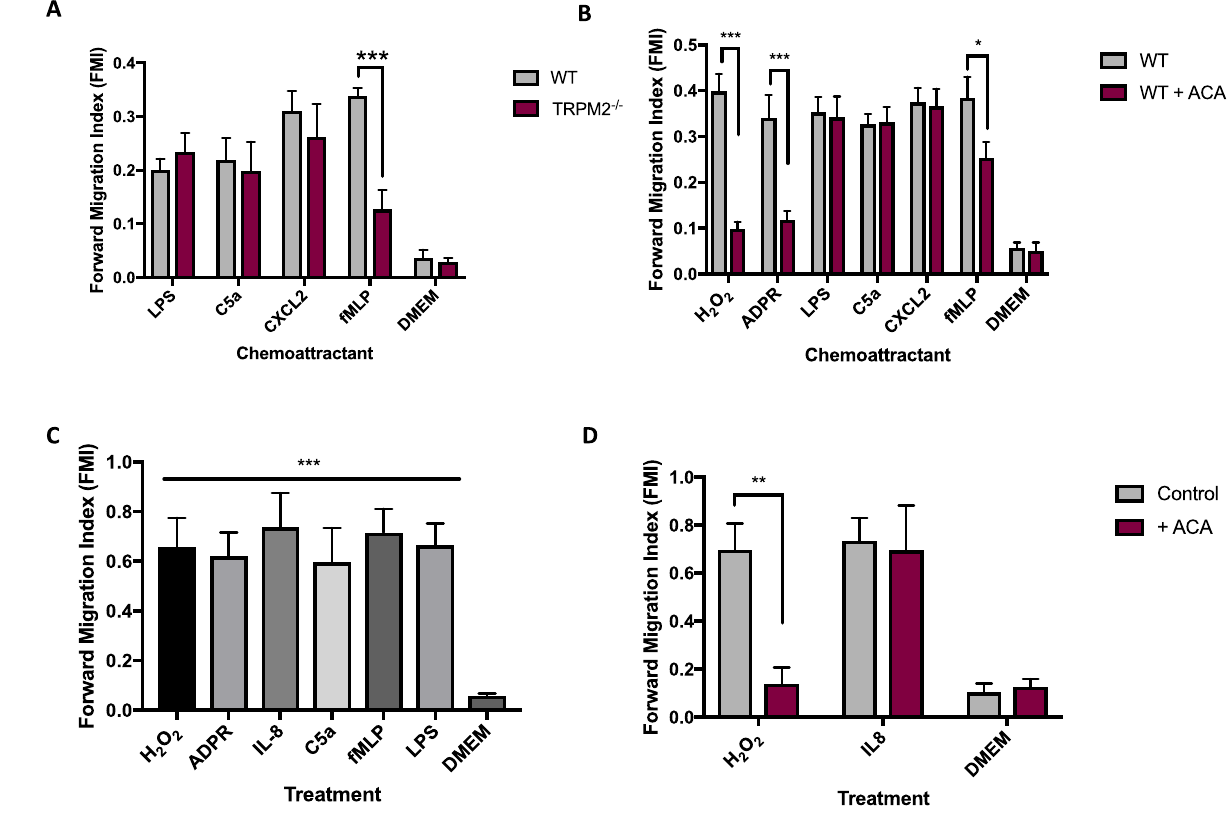
Figure 2. Dependence on TRPM2 of migration towards neutrophil chemoattractants. ( A ) Effect of genetic deletion of TRPM2 on mouse neutrophil migration. Forward migration index (FMI) in response to gradient of lipopolysaccharide (LPS, 50 ng/ml), C5a (10 nM), CXCL2 (10 nM) and fMLP (1 µM), all over 1 mm. No significant difference in FMI of WT and TRPM2 −/− neutrophils in response to LPS, C5a or CXCL2, but neutrophil migration to fMLP was significantly inhibited by TRPM2 deletion. ( B ) Effect of pharmacological block of TRPM2 with ACA (N-(p-amylcinnamoyl)anthranilic acid, 10 µM) on mouse neutrophil migration. FMI in gradient of H 2 O 2 (0.01 µM), ADPR (100 µM) and other chemoattractants as in ( A ). ( C ) Human blood neutrophil FMI in response to gradients of chemoattractants as follows, all over 1 mm: H 2 O 2 (0.01 µM), ADPR (100 µM), IL8 (10 nM), C5a (10 nM), fMLP (1 µM) and LPS (50 ng/ml). ( D ) Inhibition of human blood neutrophil FMI by TRPM2 blocker ACA (10 µM). Gradients over 1 mm: H 2 O 2 (0.01 µM), IL8 (10 nM). Statistical analysis: Mean ± SEM, independent samples from n = 3 mice or humans in each panel. ( A , B , D ): pairwise t-test comparing WT to TRPM2 −/− or ACA. ( C ) One-way ANOVA and Tukey–Kramer post-hoc test compared to DMEM. *, p < 0.05; **, p < 0.01; *** p < 0.001; ****, p < 0.0001, difference non-significant if not